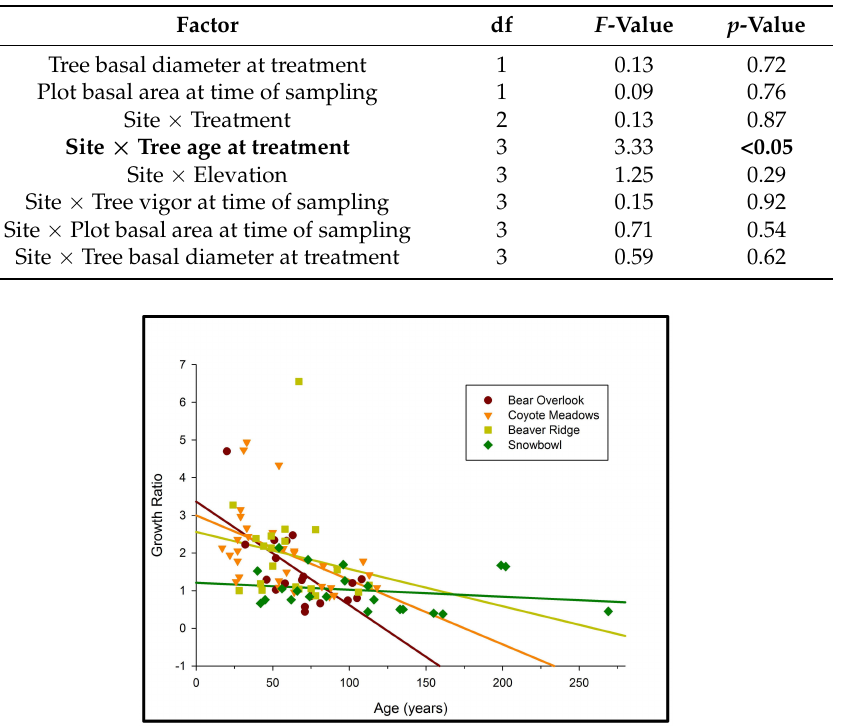
Figure 1. Relationship between growth ratio and tree age by site (CM: Coyote Meadows; SB: Snowbowl; BO: Bear Overlook; BR: Beaver